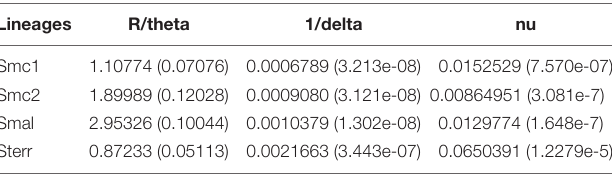
TABLE 5 | Recombination estimates for environmental isolates of the Smc1, Smc2, S. maltophilia (Smal) and S. terrae (Sterr) lineages recovered from Mexican rivers based on the concatenated dataset (3591 sites).